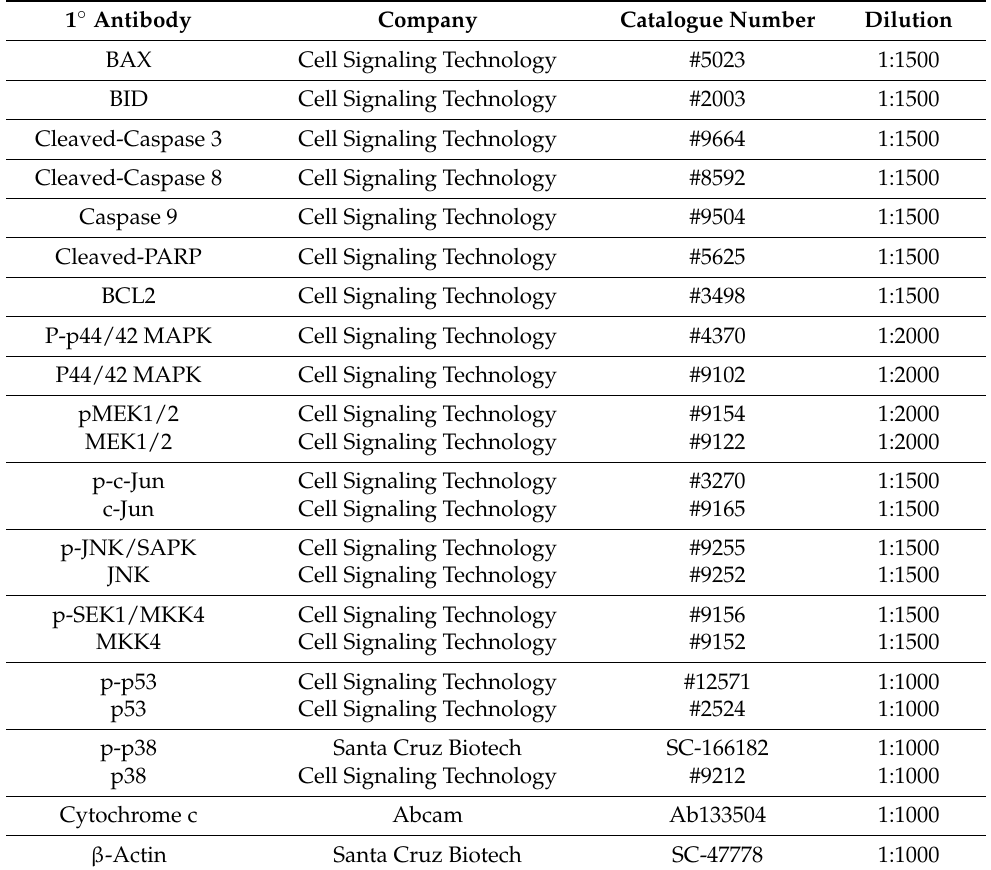
Table 2. List of antibodies used for immunostaining and